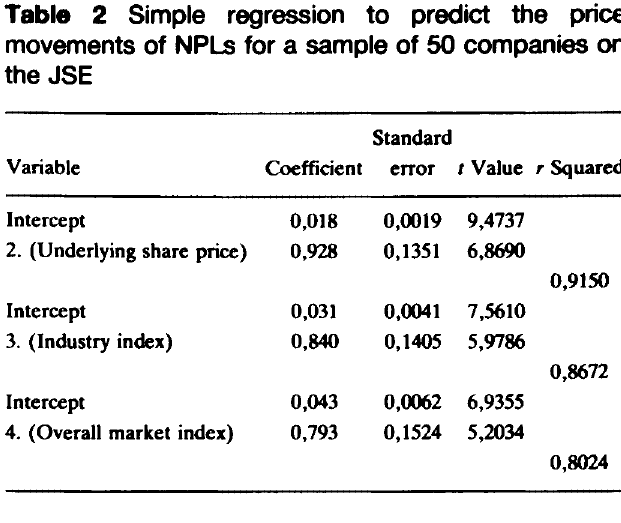
Table 2 Simple regression to predict the price movements of NPL.s for a sample of 50 companies